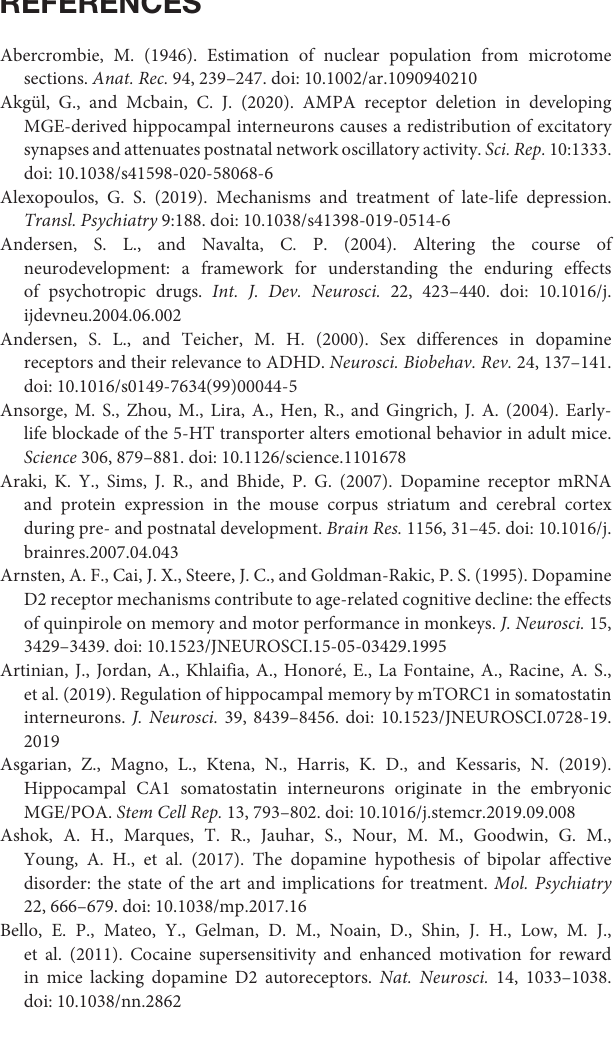
SUPPLEMENTARY FIGURE 2 | Additional Phenotyping of Nkx2.1-derived neuronal subpopulations. Offspring from Nkx2.1 -Cre and B6.Cg-Gt(ROSA)26Sortm14(CAG-tdTomato)Hze intercrosses were examined for additional markers. Images were collected with 20X objective and scale bar = 50 µ m. Sections through the body of the striatum were immunostained with antibodies against DARPP-32 (D) or CHAT (E) . Note that